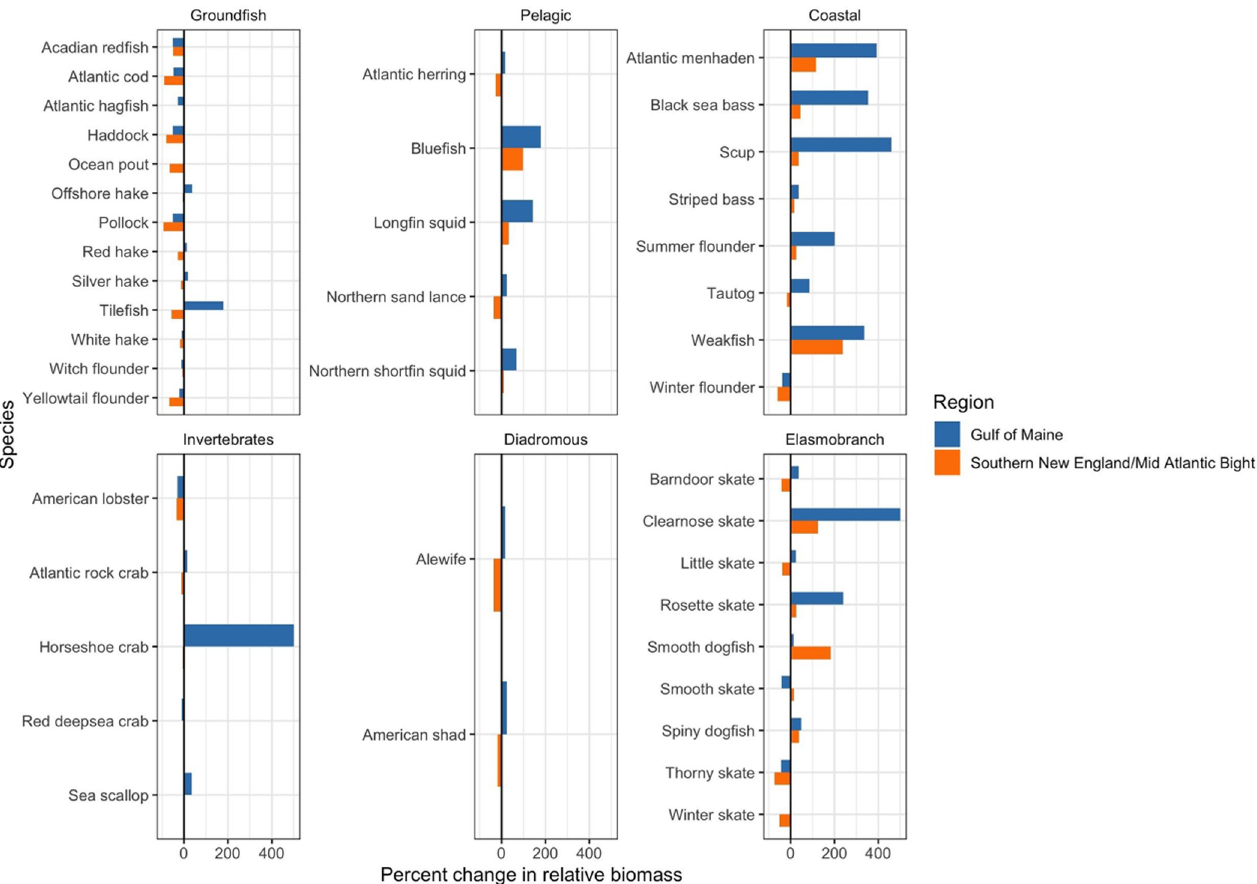
Fig 8. Spring regional projected percent changes in relative biomass by species functional group. Projected species relative biomass changes given the mean CMIP5 RCP 8.5 climate model ensemble projected sea surface temperatures. Positive percent increases were capped to 500% for horseshoe crab and clearnose skate to facilitate visualizing and comparing changes across species and climate model ensemble projected sea surface temperature